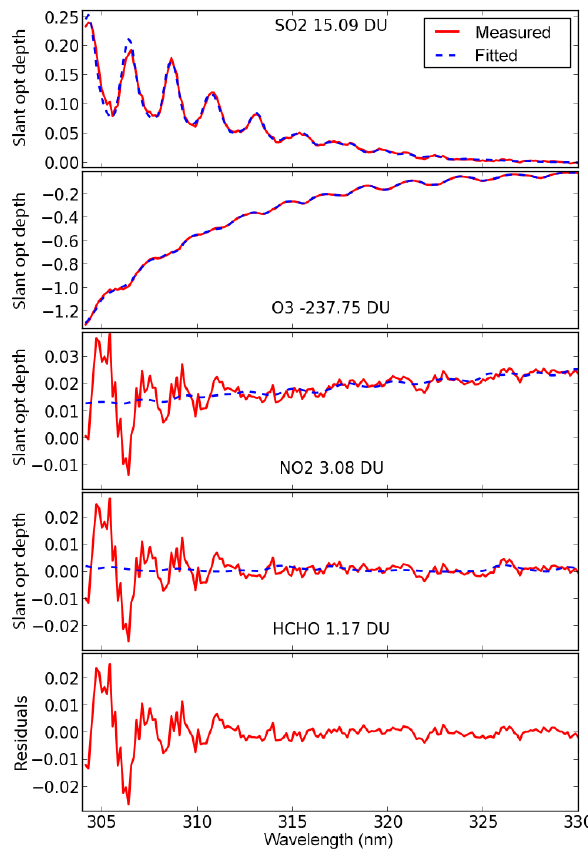
Figure 2. Fitted Pandora slant column optical depths (blue) for a measurement at Fort McKay on 2 August 2015 at 07:42 MST (red) when some of the highest SO 2 values were observed. The synthetic reference spectrum was used in the fitting (see text for details). The negative O 3 slant column means that there was more O 3 in the ref- erence than in the measurements at 07:42 MST. Note that NO 2 and HCHO are fitted in this fitting windows, but only to improve the re- sults for SO 2 . The measured (red) lines for each gas were obtained from the measured irradiance logarithm by subtracting all other fit- ting functions except the absorption spectrum-based fit for that